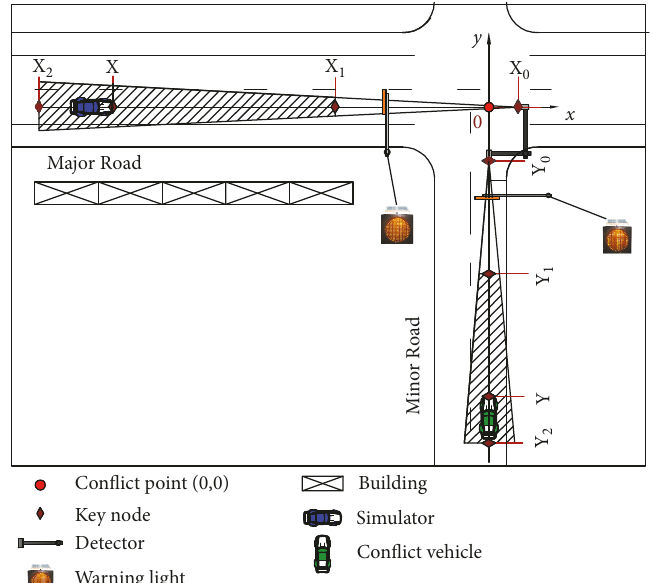
Figure 2: Design diagrams of the warning